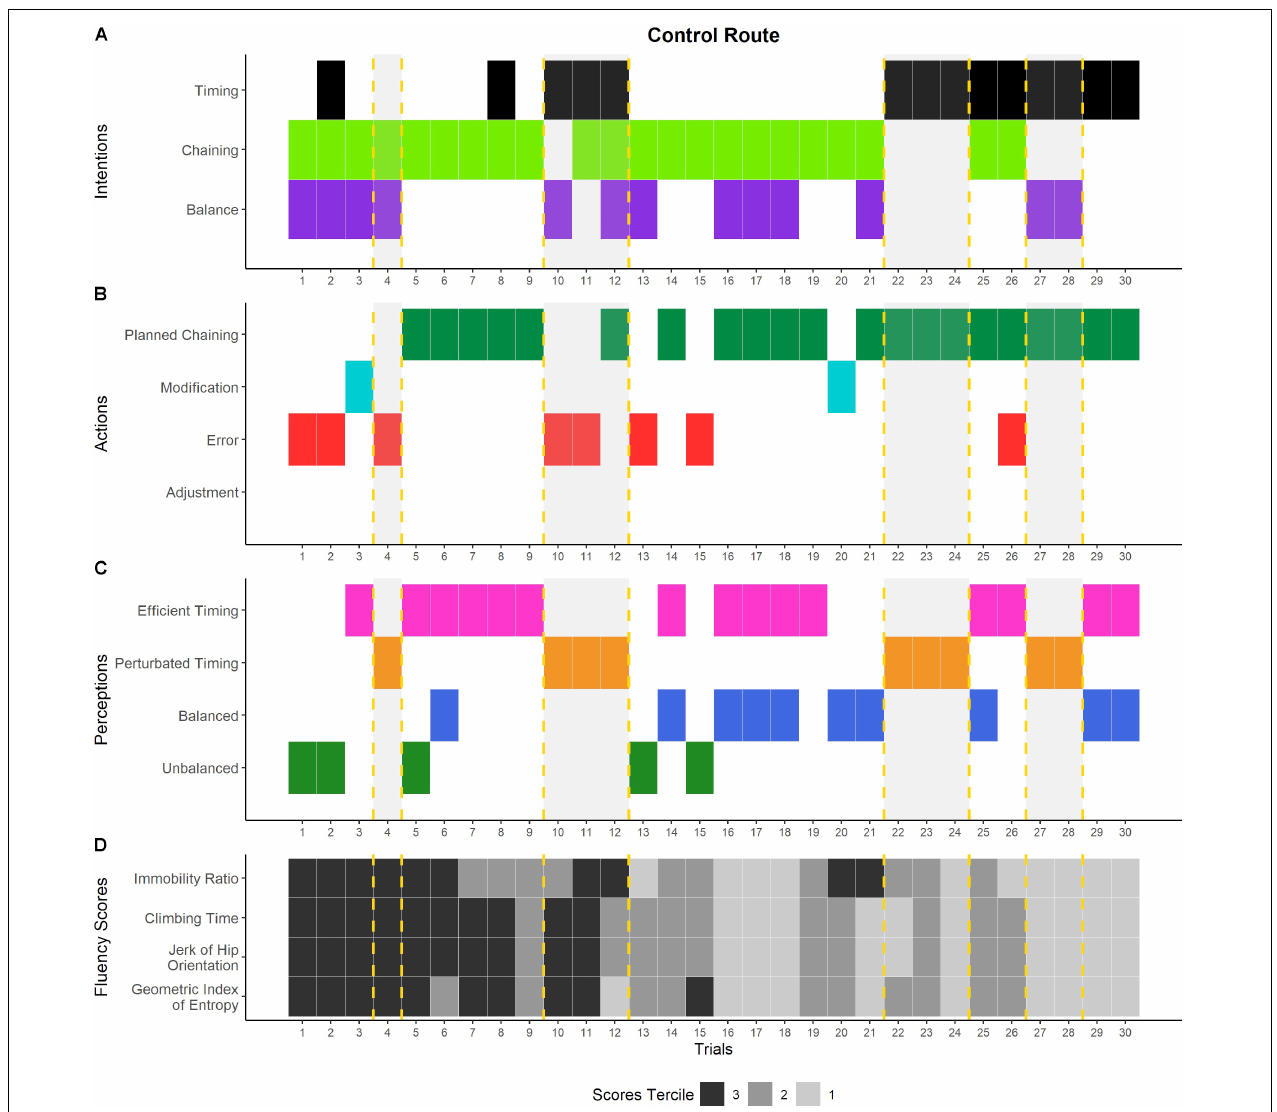
FIGURE 4 | Dynamics of the climber’s experience and performances on the control route. Panels A–C show the temporal organization of the general dimensions of the different components of experience detected during the interviews. Panel A shows the general dimensions of the climber’s intentions: Improving the timing of the climb (black), ensuring the correct execution of movement chaining (light green), and seeking and maintaining balance while climbing (purple). The climber’s actions are shown in panel B: carrying out the planned chaining (dark green), deliberately modifying the planned movements while climbing (light blue), making errors while climbing (red), and adjusting the foot chaining while climbing (gold). Panel C shows the general dimensions of the climber’s perceptions: sensation of efficient timing (pink), sensation of perturbed timing (orange), sensation of being balanced (dark blue), and sensation of being unbalanced (green). Panel D shows the score terciles for each fluency indicator. The climbing performance is expressed in the terciles: tercile 3 (in black) refers to his poorest performances, tercile 2 (in dark gray) refers to his intermediate performances, and tercile 1 (in light gray) refers to his best performances. The vertical dashed lines delimit the crucial episodes in the climber’s